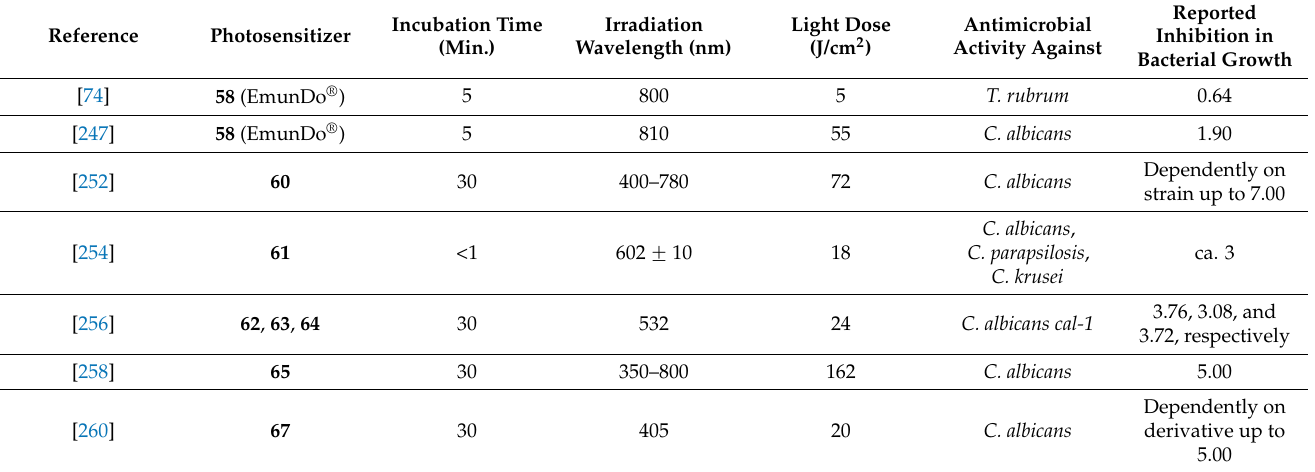
Table 7. Other photosensitizers—photodynamic antimicrobial activity and dosimetry. Reference